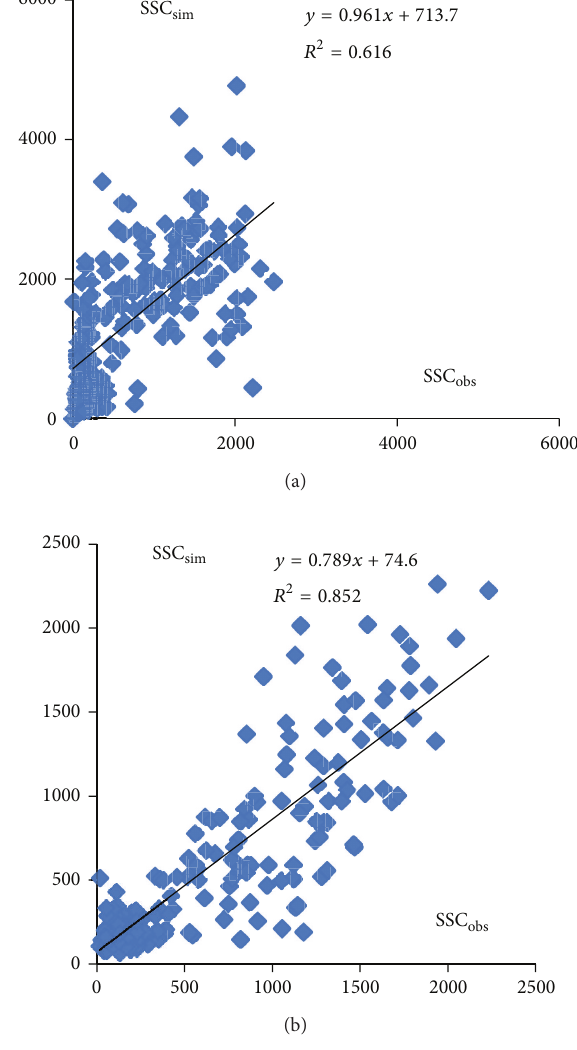
middle, and late) in three watersheds, which indicated that vegetation cover in different seasons has different